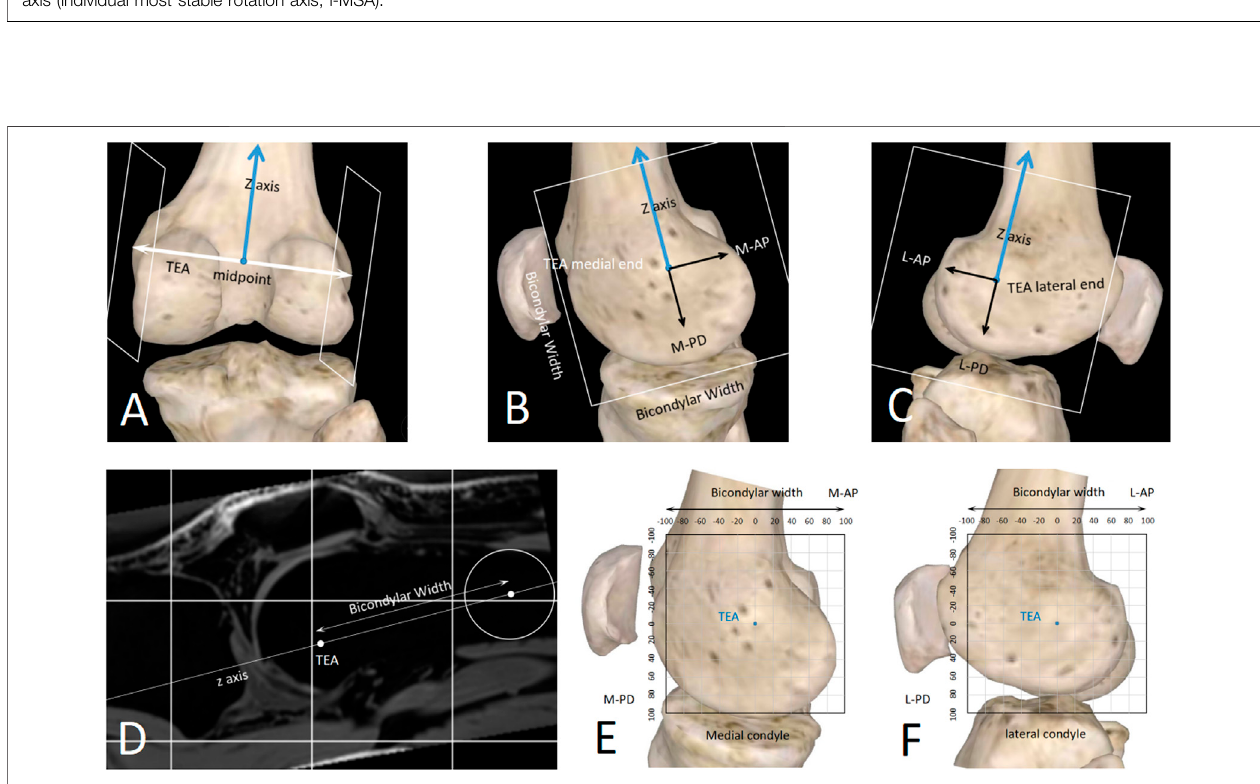
FIGURE 8 | A standardized method to describe spatial position of any straight line close to the knee joint. (A – D) The sagittal planes of the TEA medial/lateral ends were determined with the distal femur anatomy. (E,F) 2D coordinate systems were established in the sagittal planes. The unit length can be millimeter (sagittal-mm coordinate system) or bicondylar width (sagittal-BCW coordinate system).